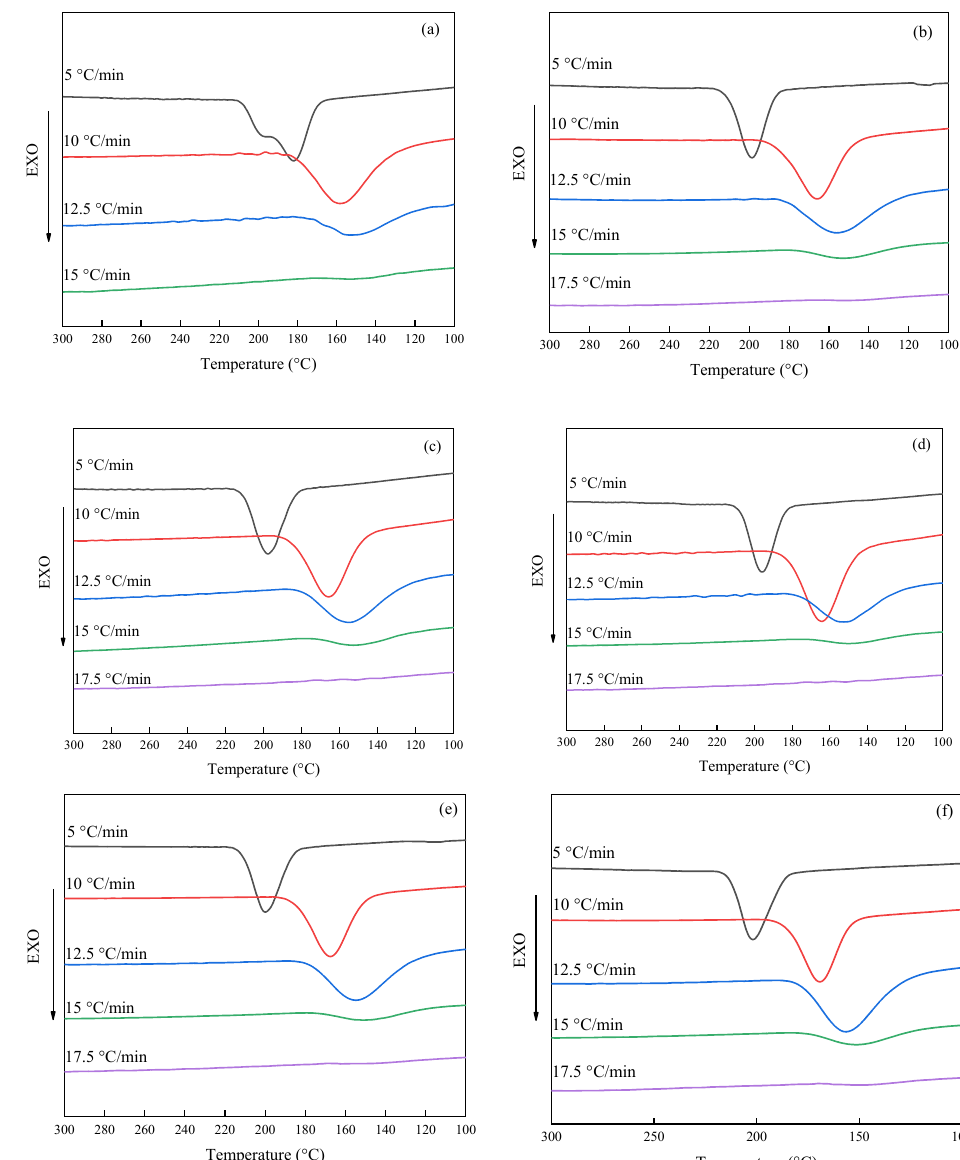
Figure 1. Non-isothermal crystallization curves of PET. ( a ) PET; ( b ) PSLDH 0.01 wt%; ( c ) PSLDH 0.03 wt%; ( d ) PSLDH 0.05 wt%; ( e ) PSLDH 0.07 wt%; ( f ) PSLDH 0.1 Table 1. Non-thermal crystallization parameters of PET and modified PET at different cooling rates.